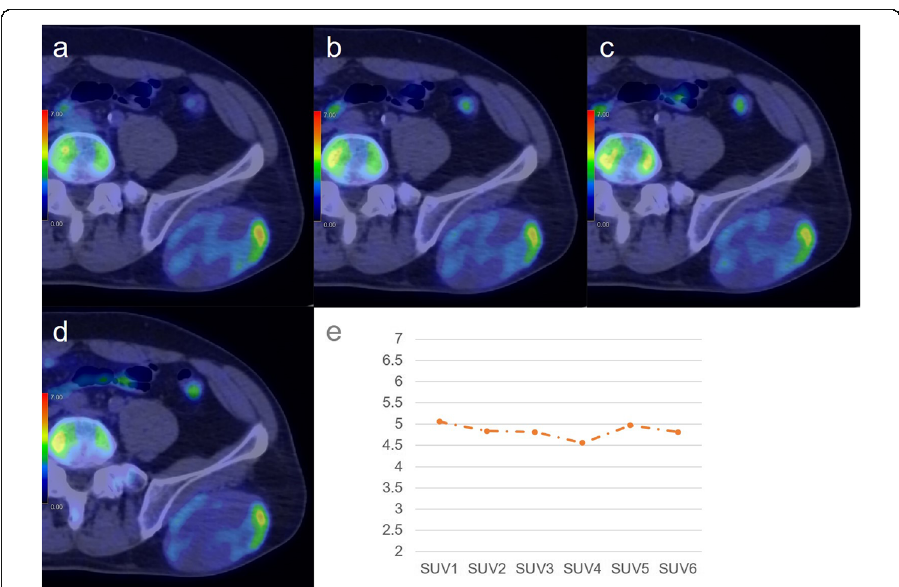
Fig. 3. A 59 year-old-man with pleomorphic leiomyosarcoma (grade 2) in the lower back. Dynamic positron-emission tomography/computed tomography (PET/CT) images are shown for the dynamic phases ( a – d ). In the dynamic first phases ( a ), the methionine accumulation in soft tissue tumours is inhomogeneous, and the focal intense accumulation is identifiable in the left portion of the tumour (SUVmax, 5.06). After the dynamic second phase ( b – d ), the focal intense accumulation gradually decreased (SUVmax: dynamic second phase ( b ), 4.84; dynamic third phase, 4.82; dynamic fourth phase ( c ), 4.56; dynamic fifth phase, 4.98; dynamic sixth phase ( d ), 4.82). The SUVmax remained relatively stable with minimal fluctuation during the dynamic phases ( e